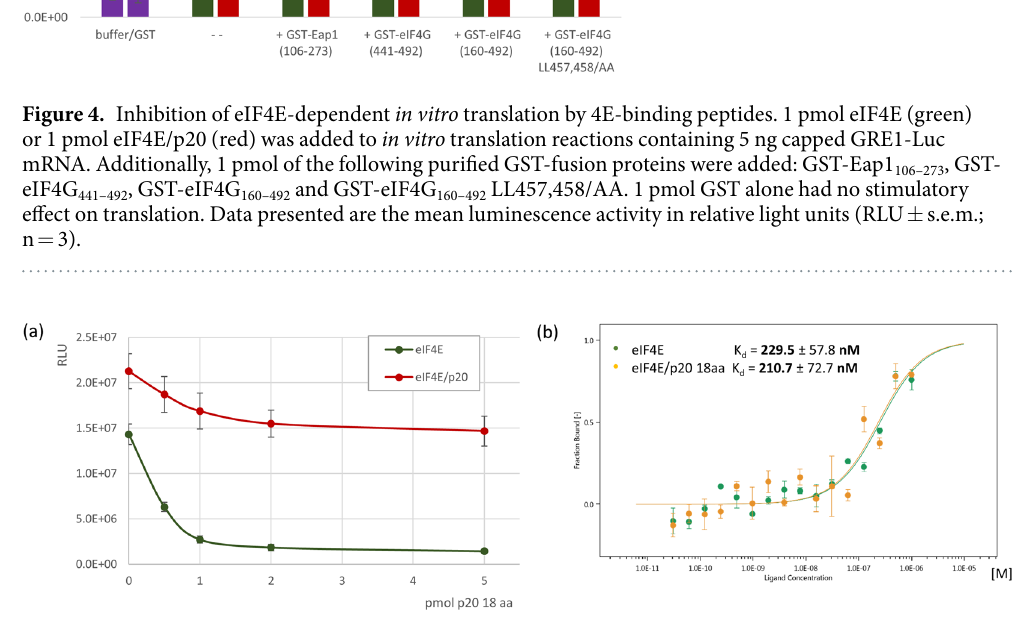
Figure 5. Effect of the N-terminal 18aa p20 peptide on translation and eIF4E binding of capped RNA. ( a ) Increasing amounts of the 18aa N-terminal p20 peptide (up to 5 pmol) were added to in vitro translational assays in the presence of 1 pmol eIF4E (green) or 1 pmol eIF4E/p20 (red). Translational assays were performed as described for Fig. 4. ( b ) MST: 50 nM RED fluorescence dye-labeled His6x-eIF4E in the absence (green) or presence of equimolar amounts of the 18aa N-terminal p20 peptide (yellow) with serially diluted m 7 GpppG- capped 64 nt long RNA (40 nt of SSA1 5 ′ UTR), starting at 1 µ M. Error bars indicate s.d. (n =